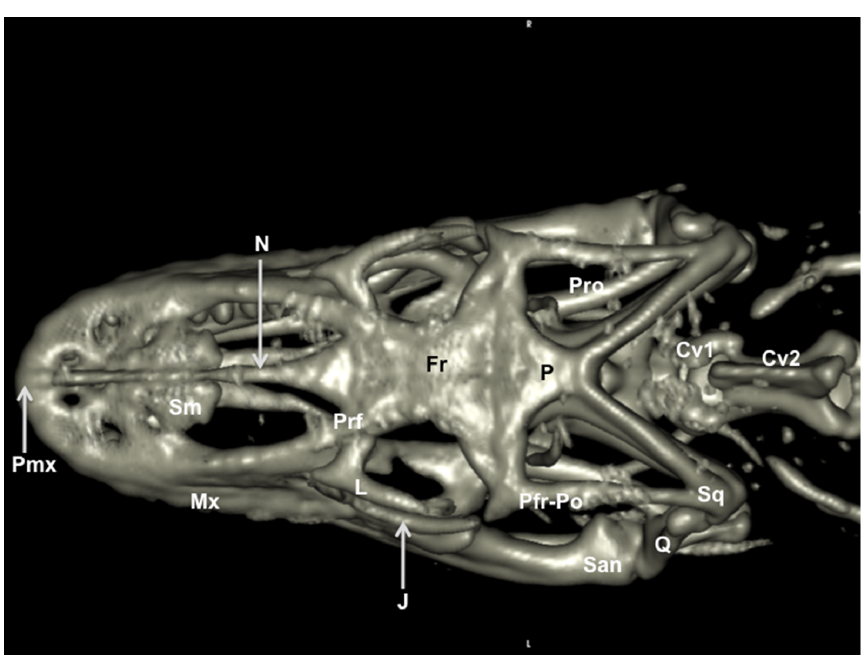
Figure 7. Three-dimensional volume-rendered reconstruction image of the cranium of Varanus komodoensis . Dorsal aspect. Pmx: Premaxillary bone. Mx: Maxillary bone. Sm: Septomaxilla. N: Nasal bone. Prf: Prefrontal bone. Fr: Frontal bone. L: Lacrimal bone. J: Jugal bone. Q: Quadrate bone. Sq: Squamosal. Pfr-Po: Postfrontal + postorbital. P: Parietal. Pro: Prootic. San: Surangular bone. Cv1: First cervical vertebra. Cv2: Second cervical vertebra.